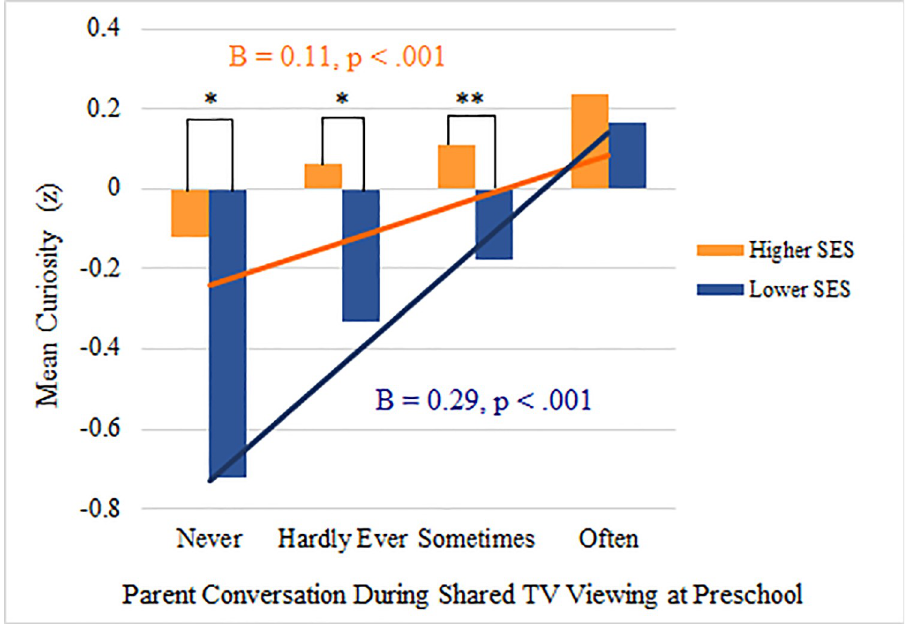
Fig 1. Frequency of parent conversation during shared media viewing at preschool and mean curiosity at kindergarten, stratified by higher and lower socioeconomic status (SES). B coefficients are unstandardized betas. Bars indicate parent conversation during TV viewing examined as a categorical variable. Lines indicate parent conversation during TV viewing examined as a continuous variable, to test and confirm the linear trend. � : p < .05; ��